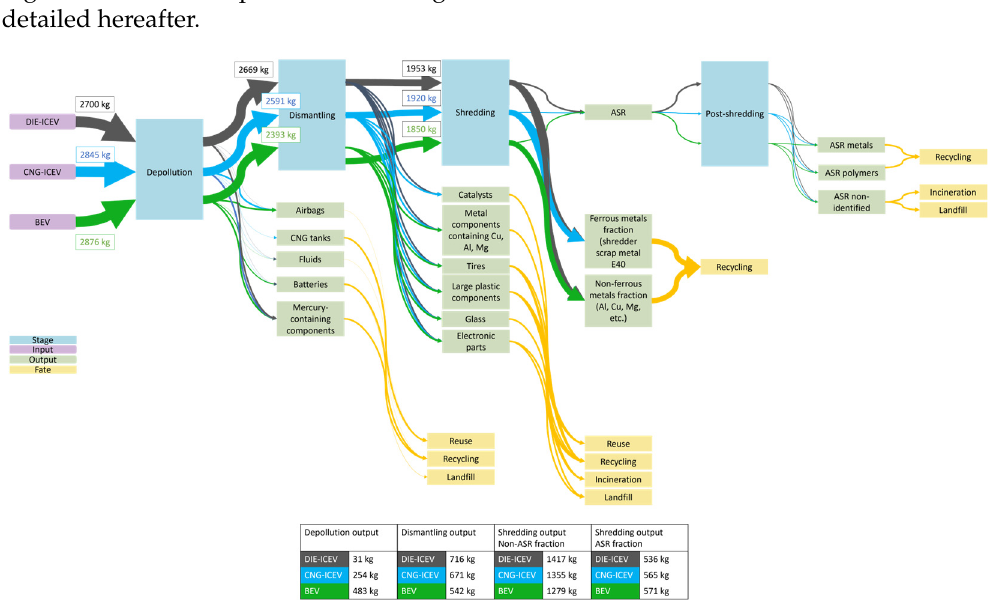
Figure 2. Flowchart of the waste management scheme of the three vehicles.